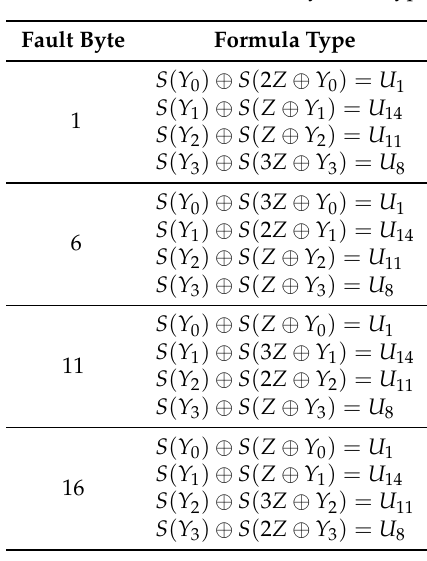
Table 1. Formula classification by Fault